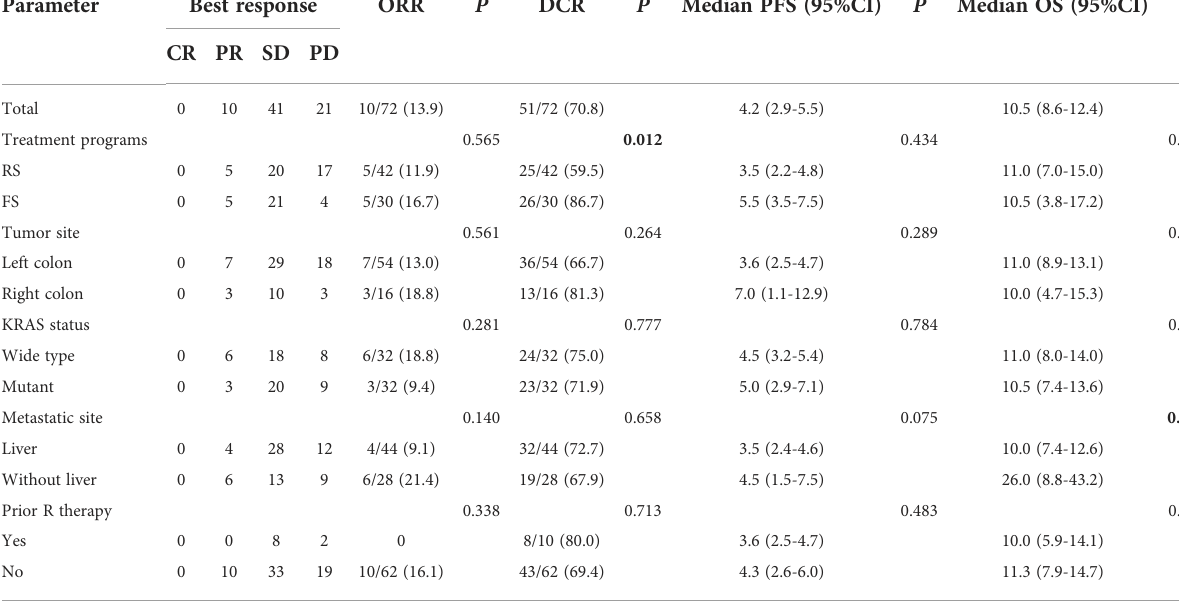
TABLE 2 Ef fi cacy of regorafenib or fruquintinib plus sintilimab in metastatic MSS colorectal cancer.